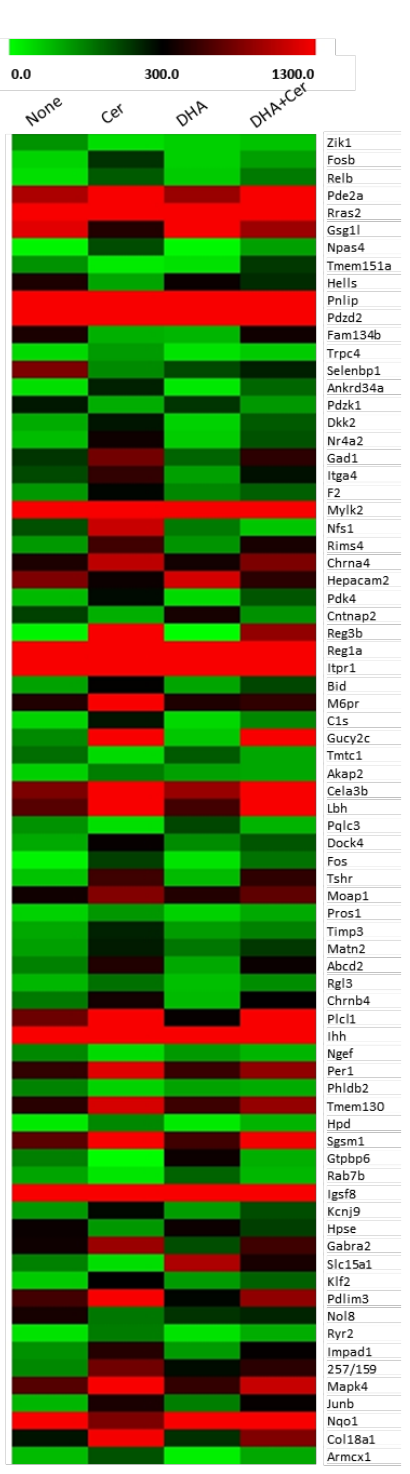
Figure 1. Heatmap of differentially expressed genes (DEGs) that are significantly altered by cerulein treatment, or by pretreatment with docosahexaenoic acid (DHA) followed by cerulein treatment. AR42J cells were treated with a vehicle (designated as ‘none’) or DHA (50 µ M) dissolved in vehicle (designated as ‘DHA’) for 6 h. For cerulein treatment, the cells were pretreated with a vehicle (designated as ‘cerulein’) or DHA (50 µ M) dissolved in vehicle for 2 h and then stimulated with cerulein (10 − 8 M) (designated as ‘cerulein + DHA’) for 4 h. Vehicle is 0.5 M ethanol. Heatmap was drawn based on normalized read counts represented as FPKM (fragment per kilobase of transcript per million mapped